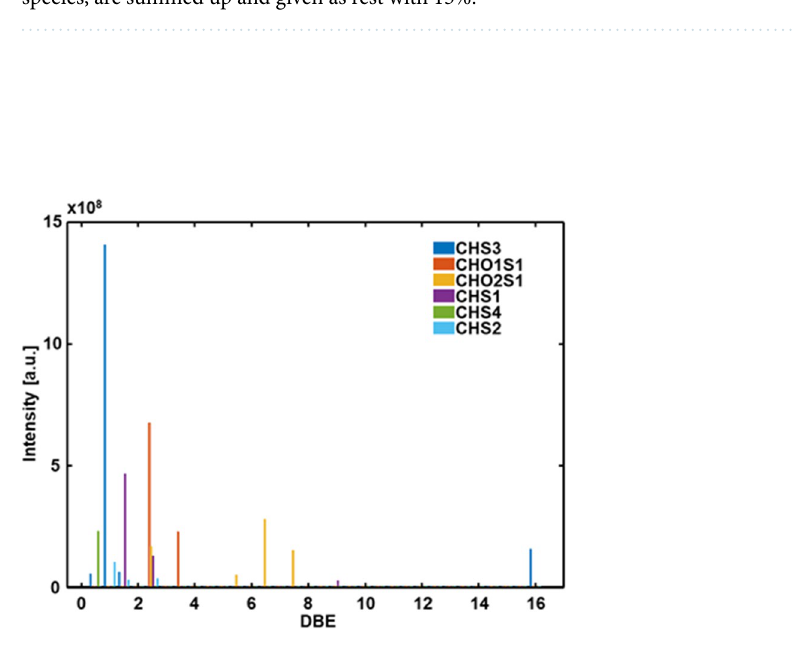
Figure 3. Summed double bond equivalent (DBE) distribution for the Sulphur-containing compound classes in Murchison IOM. The oxygenated Sulphur-species are found to have rather low DBE for one Oxygen-atom (CHSO 1 ) and increased aromaticity for the species with two Oxygen-atoms (CHS 1 O 2